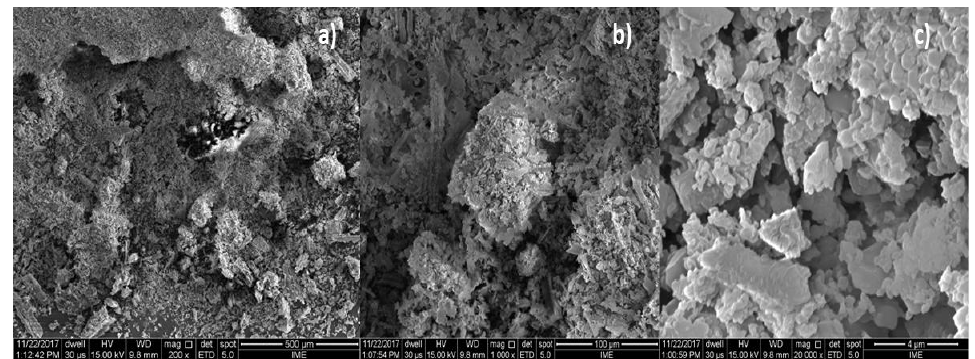
Figure 8. SEM of hydro-chars obtained by the hydrothermal processing of corn stover at 250 °C, biomass/H 2 O ratio of 1:10 and 240 min using a reactor of 18.75 L (MAG: 200× ( a ); MAG: 1000× ( b ); MAG: 20,000× ( c )).